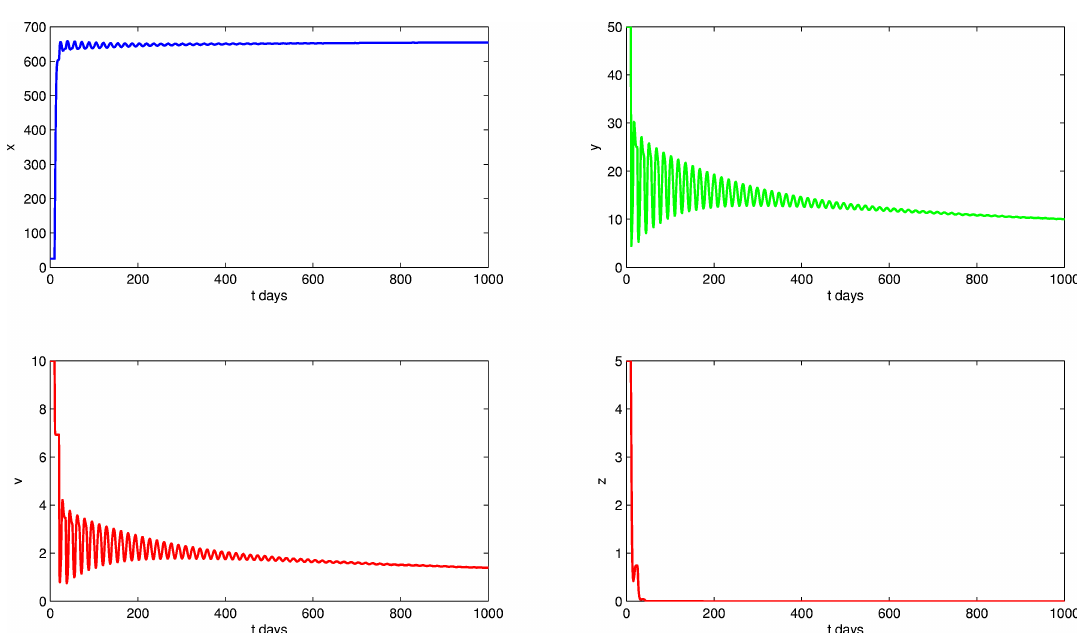
Fig. 2. Global stability of CTL-IE E 1 for R 0 > 1 > R 1